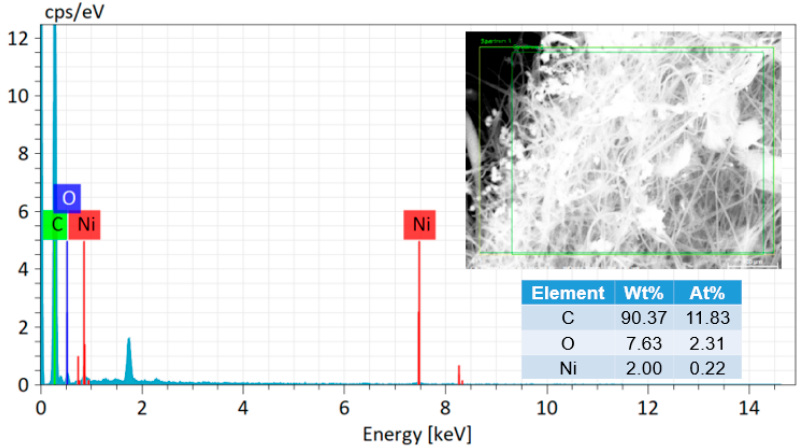
Figure 4. SEM and energy dispersive X-ray analysis (EDX) analysis of resulting carbon nano- fibrous felt.